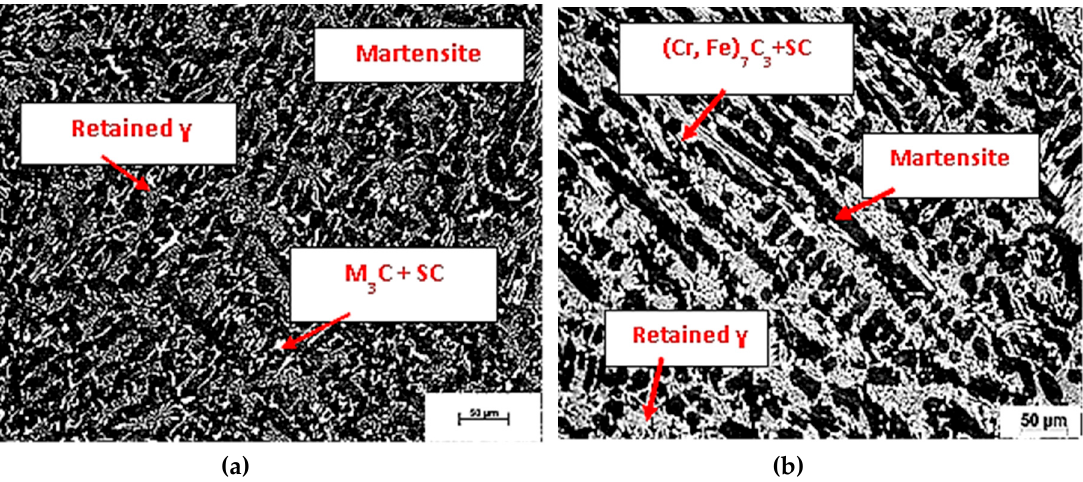
Figure 3. Optical microstructure of the conventional heat treatment (CHT) samples ( a ) S1 sample ( b ) S2 sample.